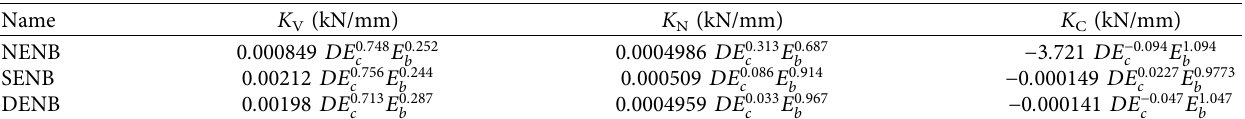
Figure 6: Initial coupling stiffness. Table 4: The empirical